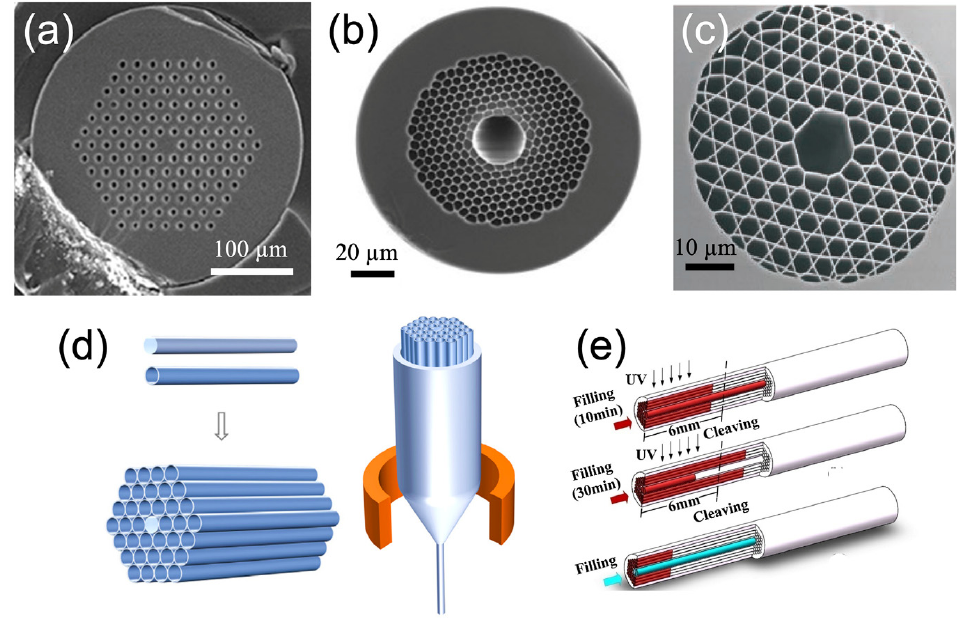
Figure 3. Design and fabrication of PCF. ( a ) A solid-core photonic crystal fiber, adapted with per ‐ mission from [133]. ( b ) A hollow ‐ core photonic crystal fiber (HC ‐ PCF) with an expanded central channel suitable for admitting whole human cells, adapted with permission from [147]. ( c ) An al ‐ ternative HC ‐ PCF with the Kagome design pattern, optimized for gas ‐ phase detection, adapted with permission from [148]. ( d ) A schematic for the thermal pulling of a preform into a thin fiber with the same structure, adapted with permission from [142]. ( e ) A schematic of the multiple cleavage method for selective filling of the hollow core with a fluorescent species, adapted with permission from [145].